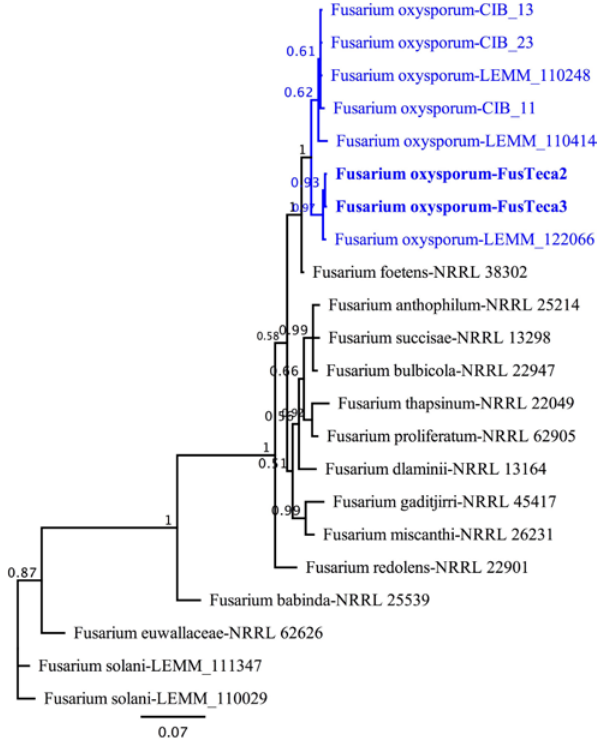
Figure 4. Phylogenetic tree obtained by Bayesian inference (GTR+G model) of the concatenated partial translation elongation factor1-α (TEF1-α) and RNA polymerase second largest subunit (RPB2) genes sequences along with other 20 reference Fusarium isolates available at the